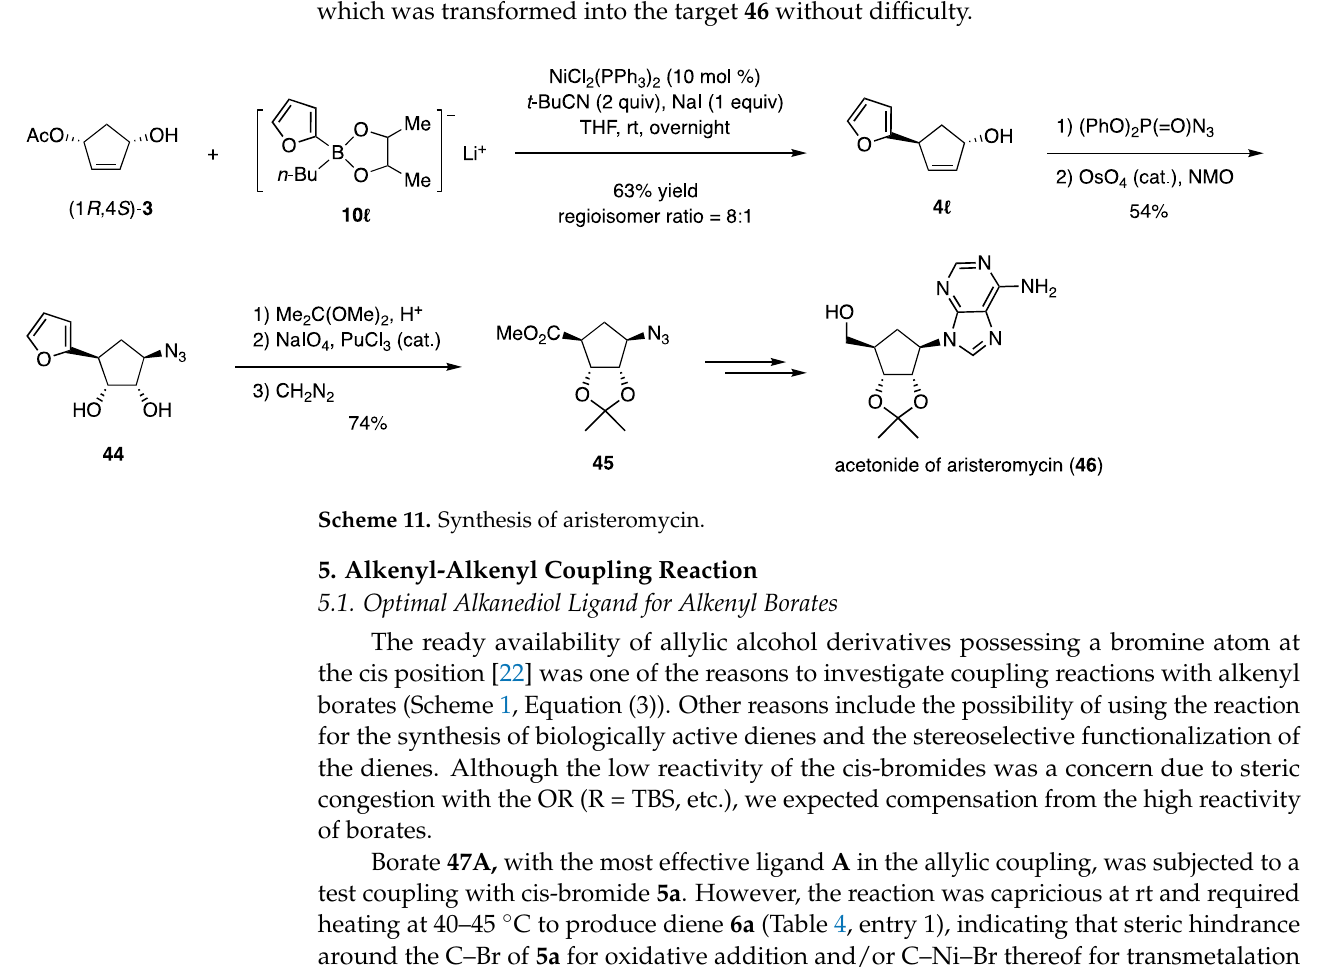
Table 4. Preliminary coupling reaction of (cis-bromo)olefin 5a with alkenyl borates possessing diol